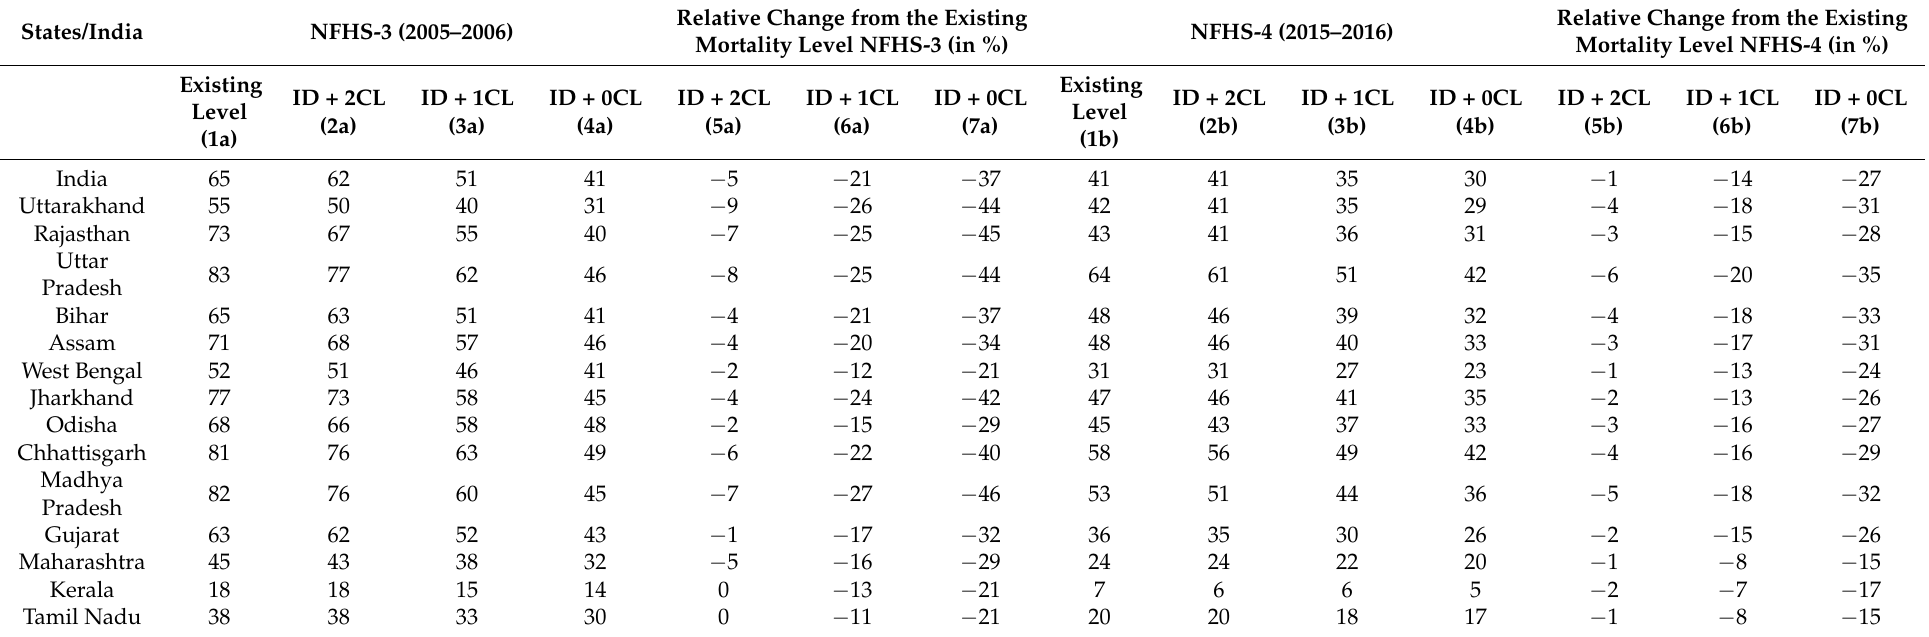
Table 4. Simulation analysis of clustering of infant deaths in India and selected states, 2005–2006 and